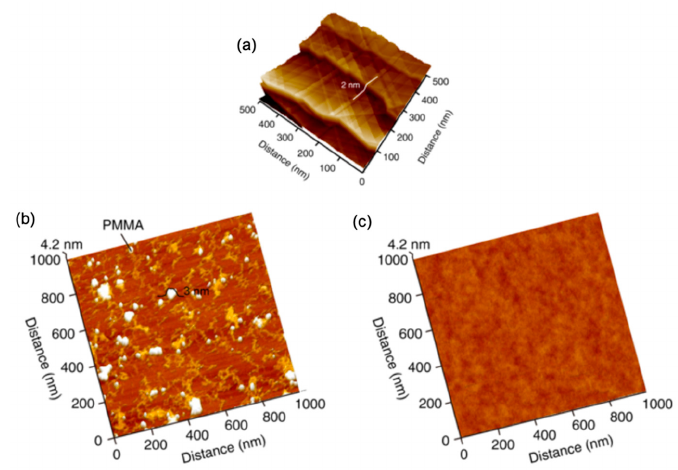
Figure 32. AFM images of ( a ) super-clean graphene freshly grown on Cu substrate, and transferred graphene on target substrate ( b ) unclean graphene and ( c ) super clean graphene (reprinted with permission from [203]).